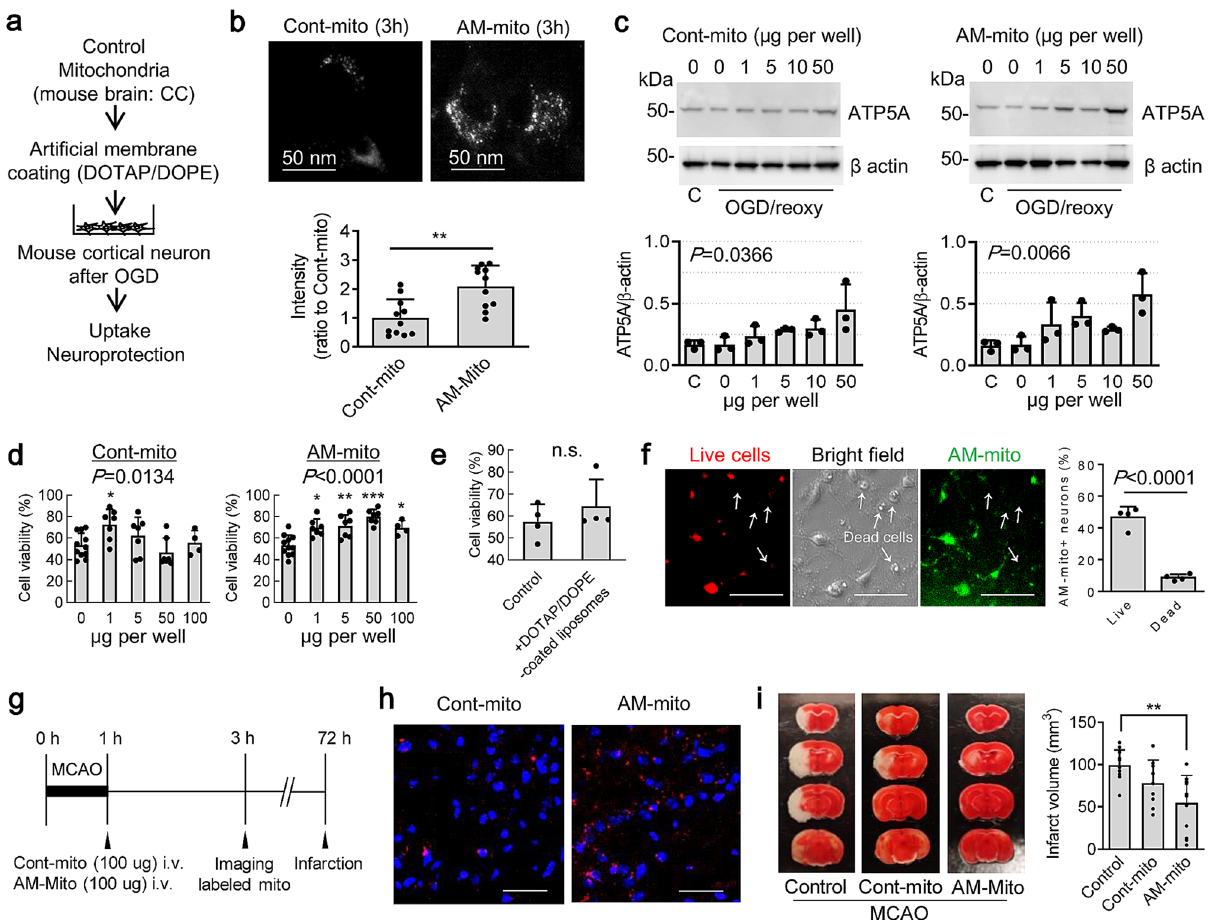
glucose deprivation (OGD) for 2 h, then control mitochondria or AM-mito were added onto the injured neurons and evaluated mitochondrial transfer